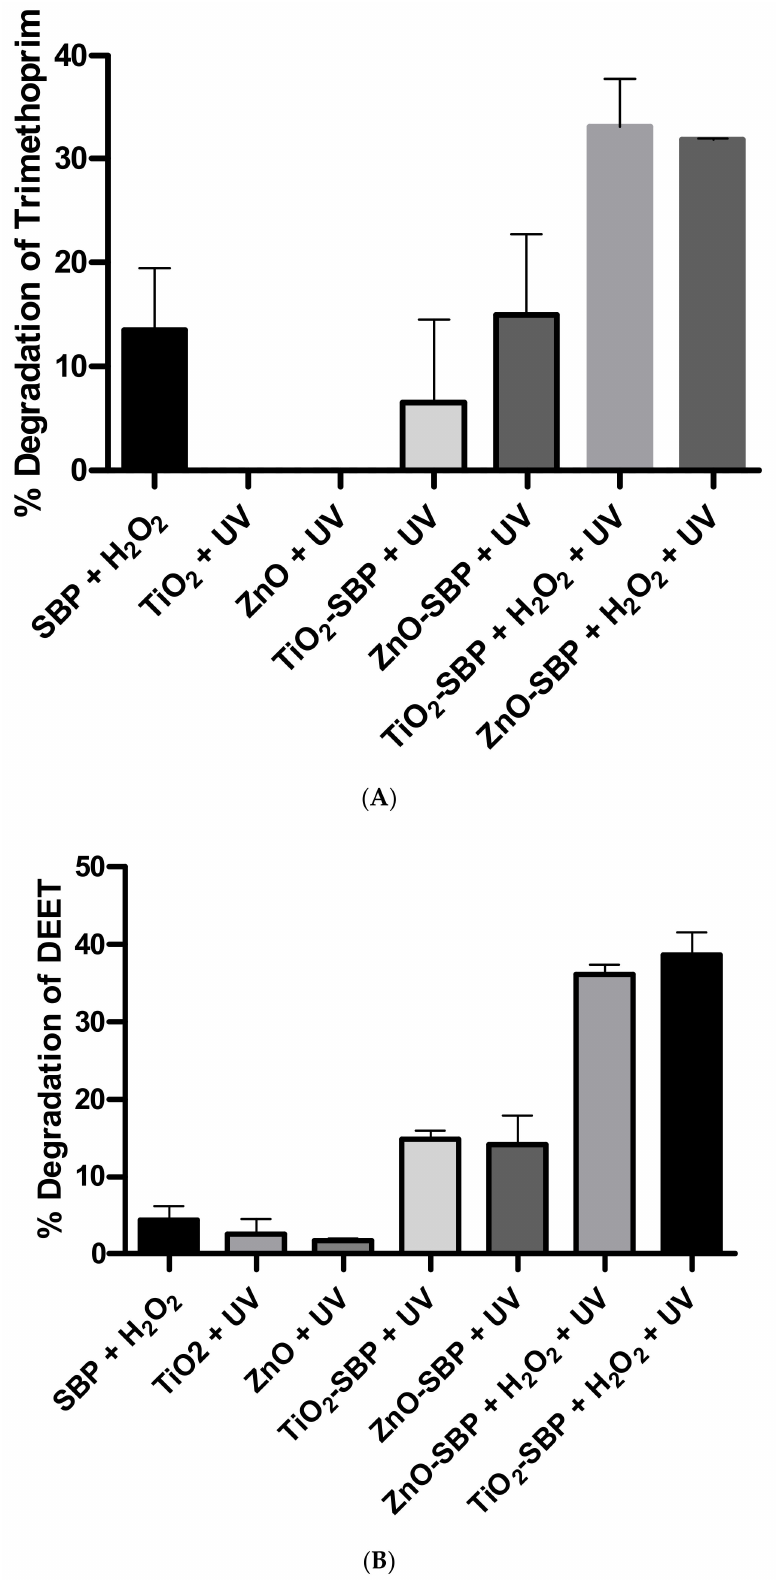
Figure 5. Percentage degradation of ( A ) Trimethoprim; and ( B ) DEET. Experimental conditions were as per Materials and